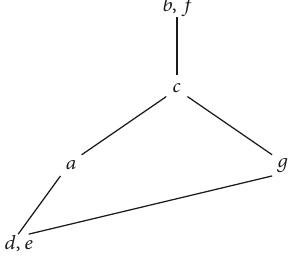
Figure 4: The topology of a network